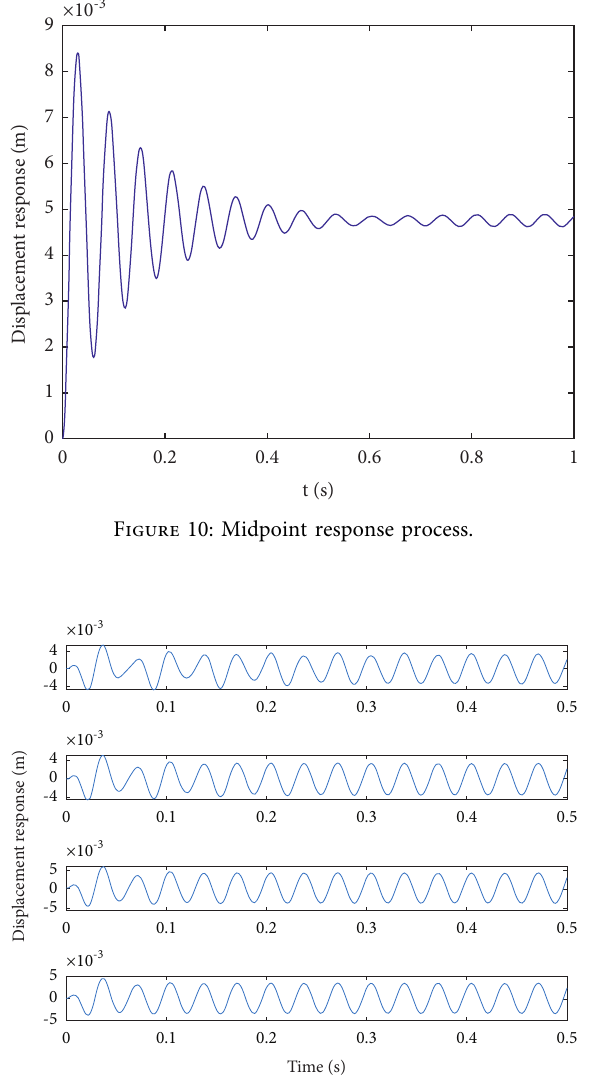
Figure 11: Time-domain response of midpoint displacement under different damping.